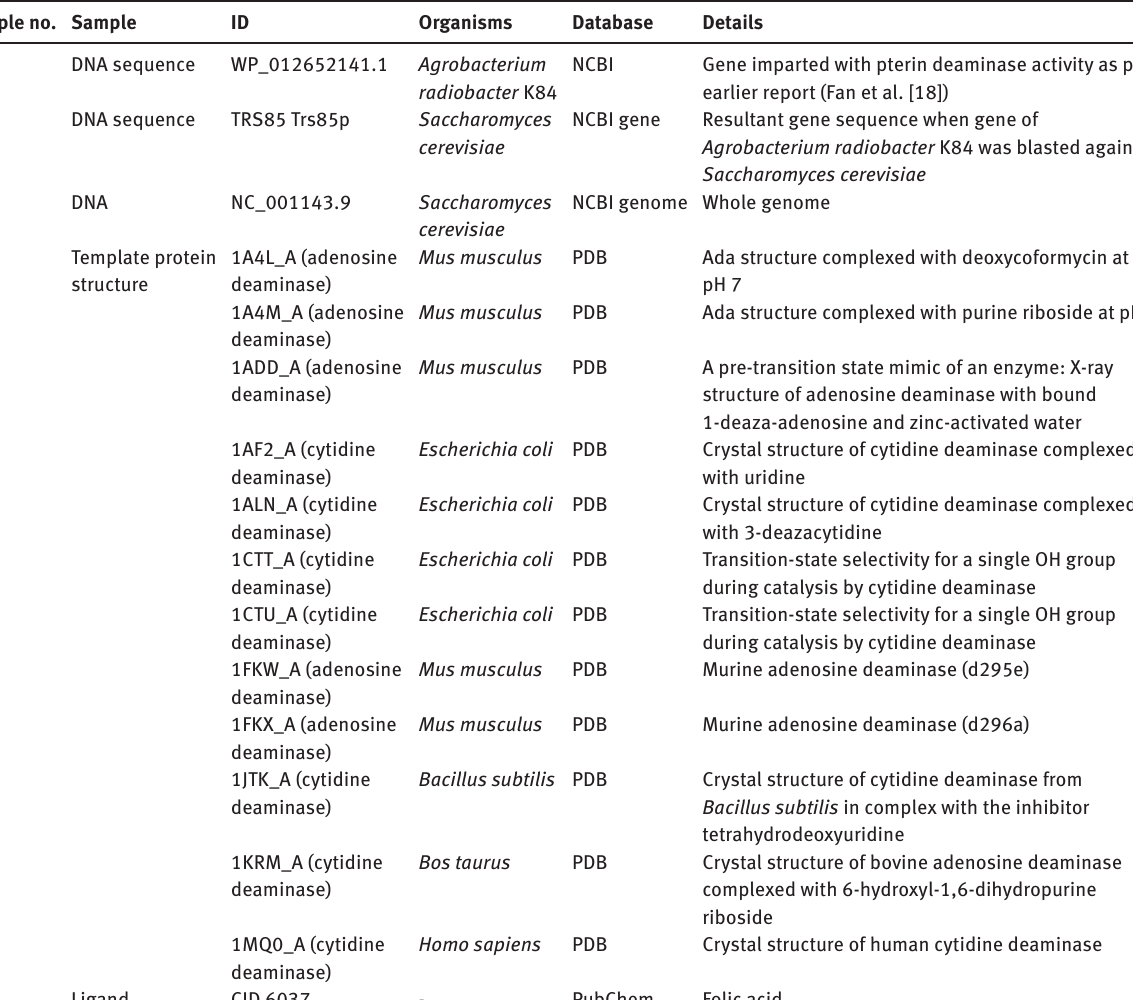
Table 3: List of DNA and protein sequences and template structures retrieved from databases. Sample no.